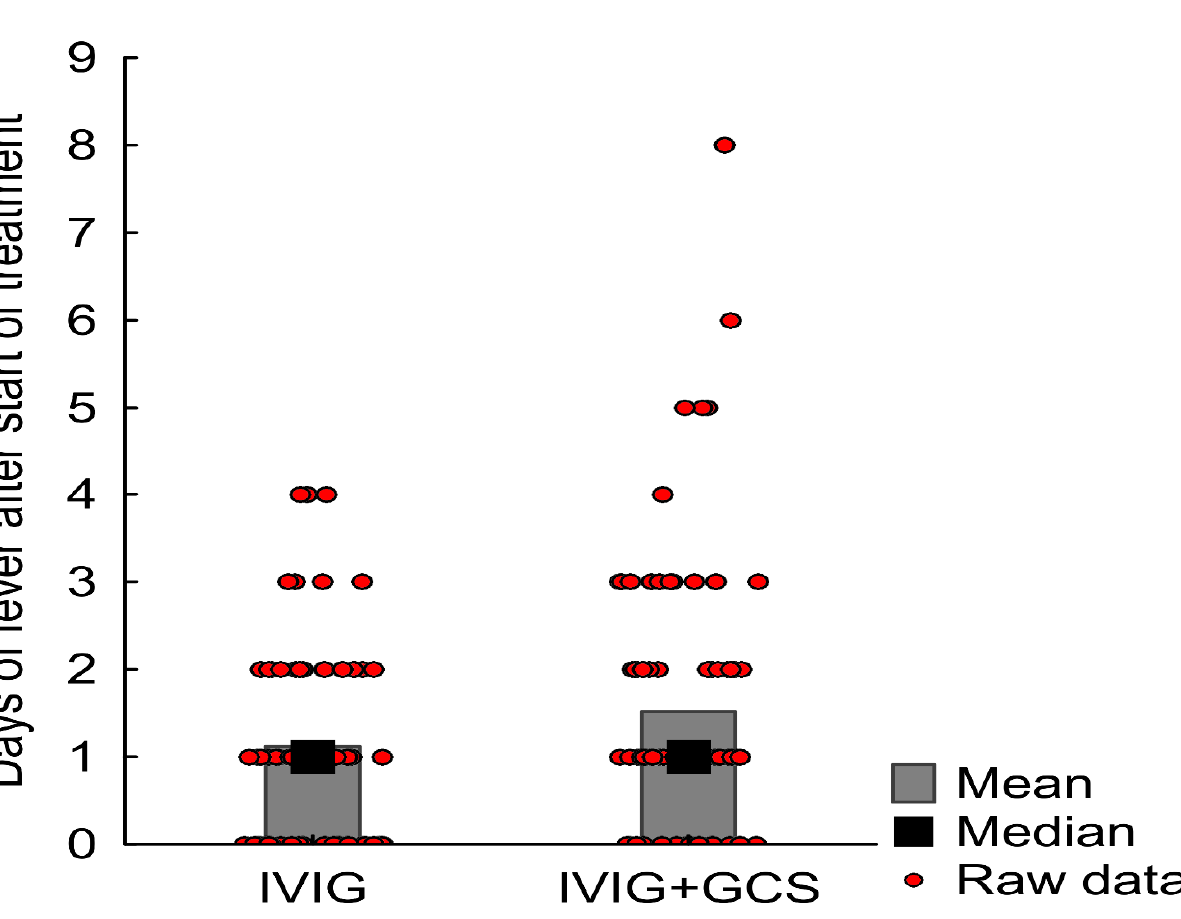
Figure 2. The effect of GCS on the duration of fever. GCS—glucocorticoids, IVIG—intravenous im- munoglobulins.